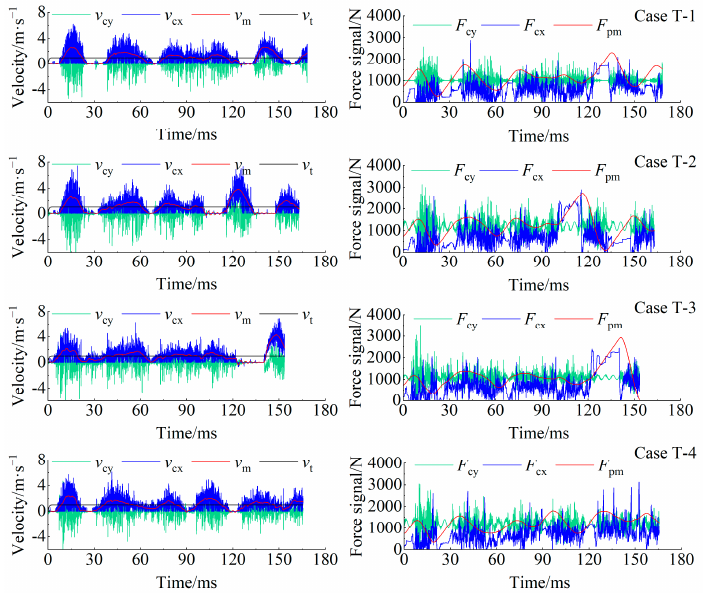
Figure 14. Simulation results of velocity and force signals.